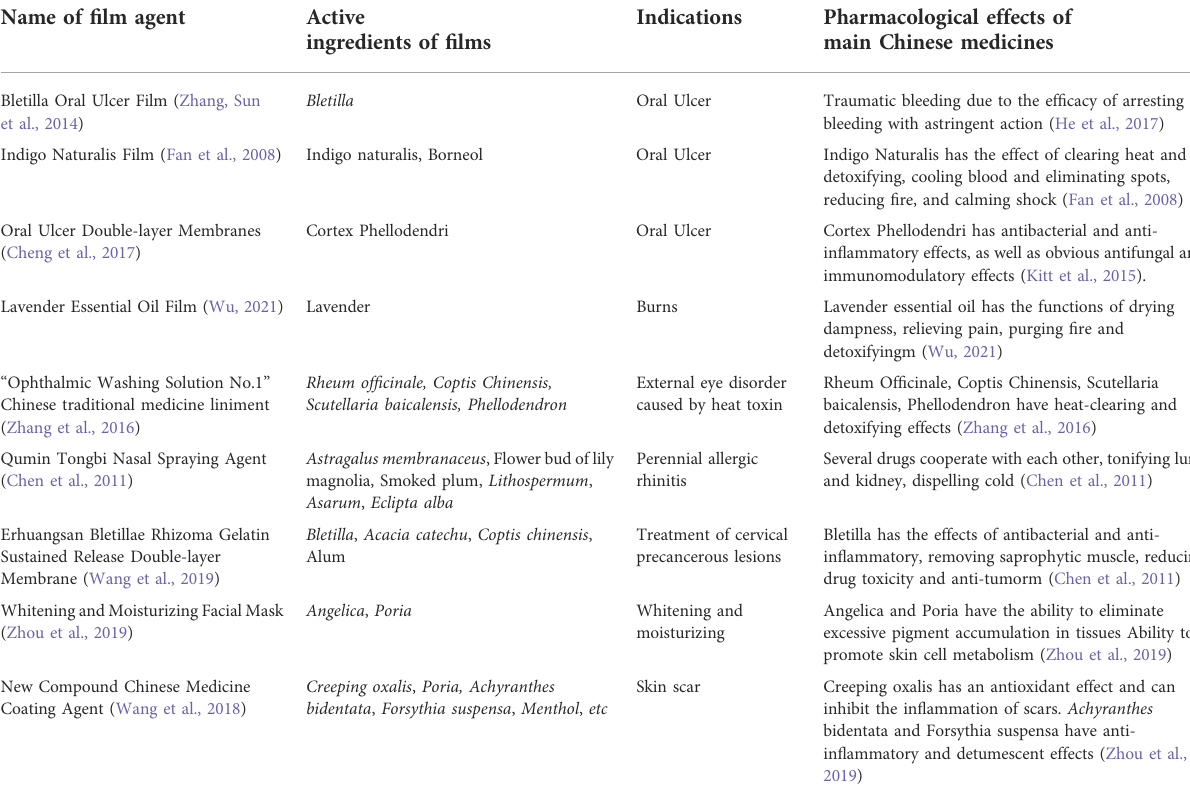
TABLE 2 Traditional Chinese medicine components and pharmacological action of fi lm